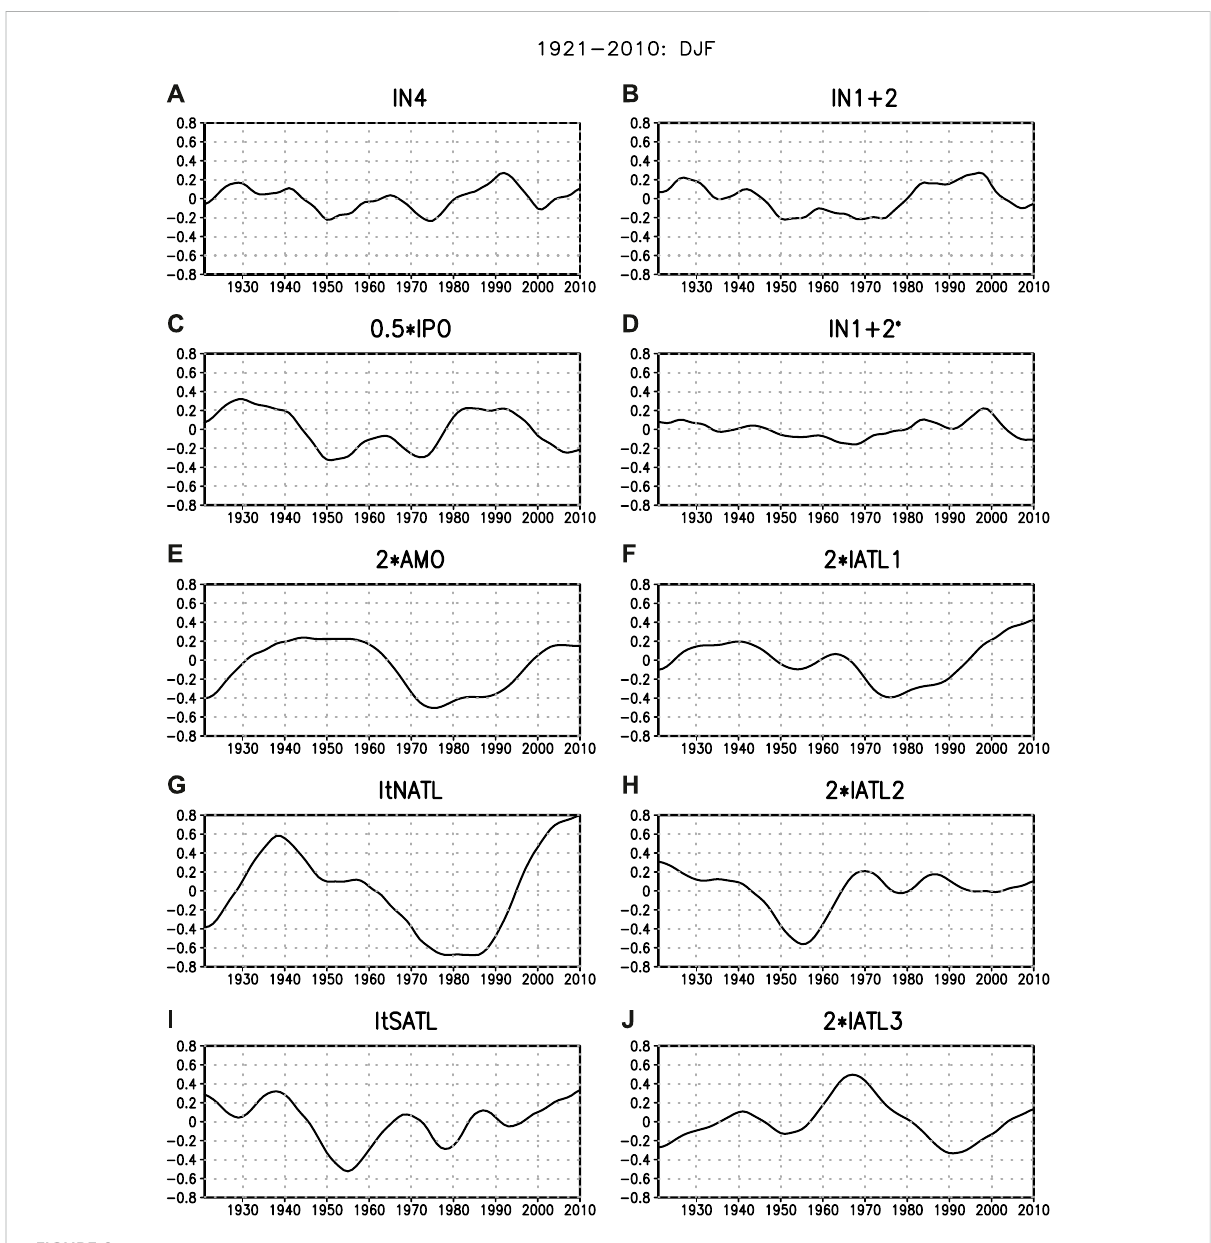
FIGURE 2 The DJF standardized time series of (A) Interdecadal Niño 4 (IN4) index, (B) Interdecadal Niño 1 + 2 (IN1+2) index, (C) Interdecadal Paci fi c Oscillation (IPO), (D) Interdecadal Niño 1 + 2 index with the Niño 3.4 in fl uence removed (IN1+2*), (E) Atlantic Multidecadal Oscillation (AMO), (F) the fi rst rotated principal component of the interdecadal variability of the Atlantic SST (IATL1), (G) Interdecadal tropical North Atlantic (ItNATL) index, (H) the second rotated principal variability of the interdecadal variability of the Atlantic SST (IATL2), (I) Interdecadal tropical South Atlantic (ItSATL) index, and (J) the third rotated principal component of the interdecadal variability of the Atlantic SST (IATL3). Note that the y-axis scale in (E) , (F) , (H) and (J) was rescaled by a factor of